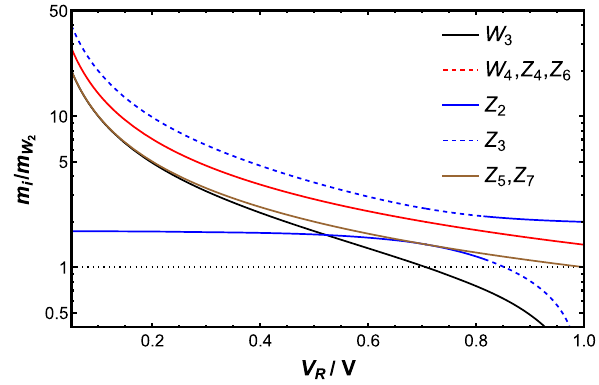
as a function of V R / V 2